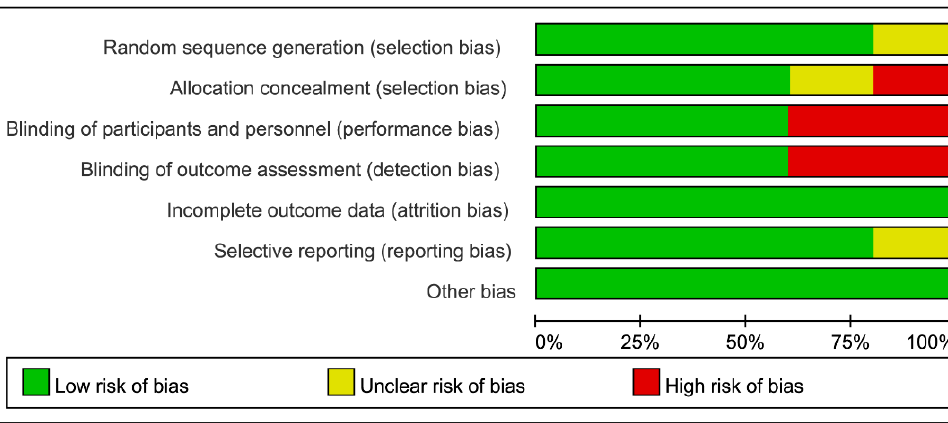
Figure 3. Overall risks of bias of the five included studies.